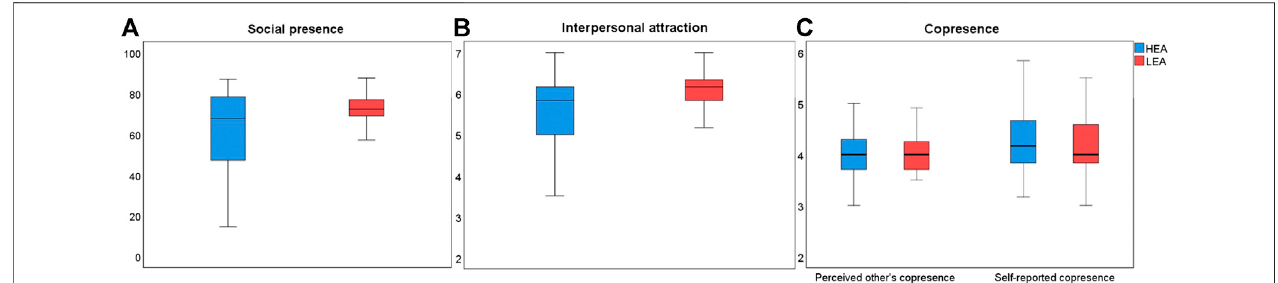
FIGURE 6 | Statistical results. (A) Social presence, (B) interpersonal attraction, and (C) copresence.